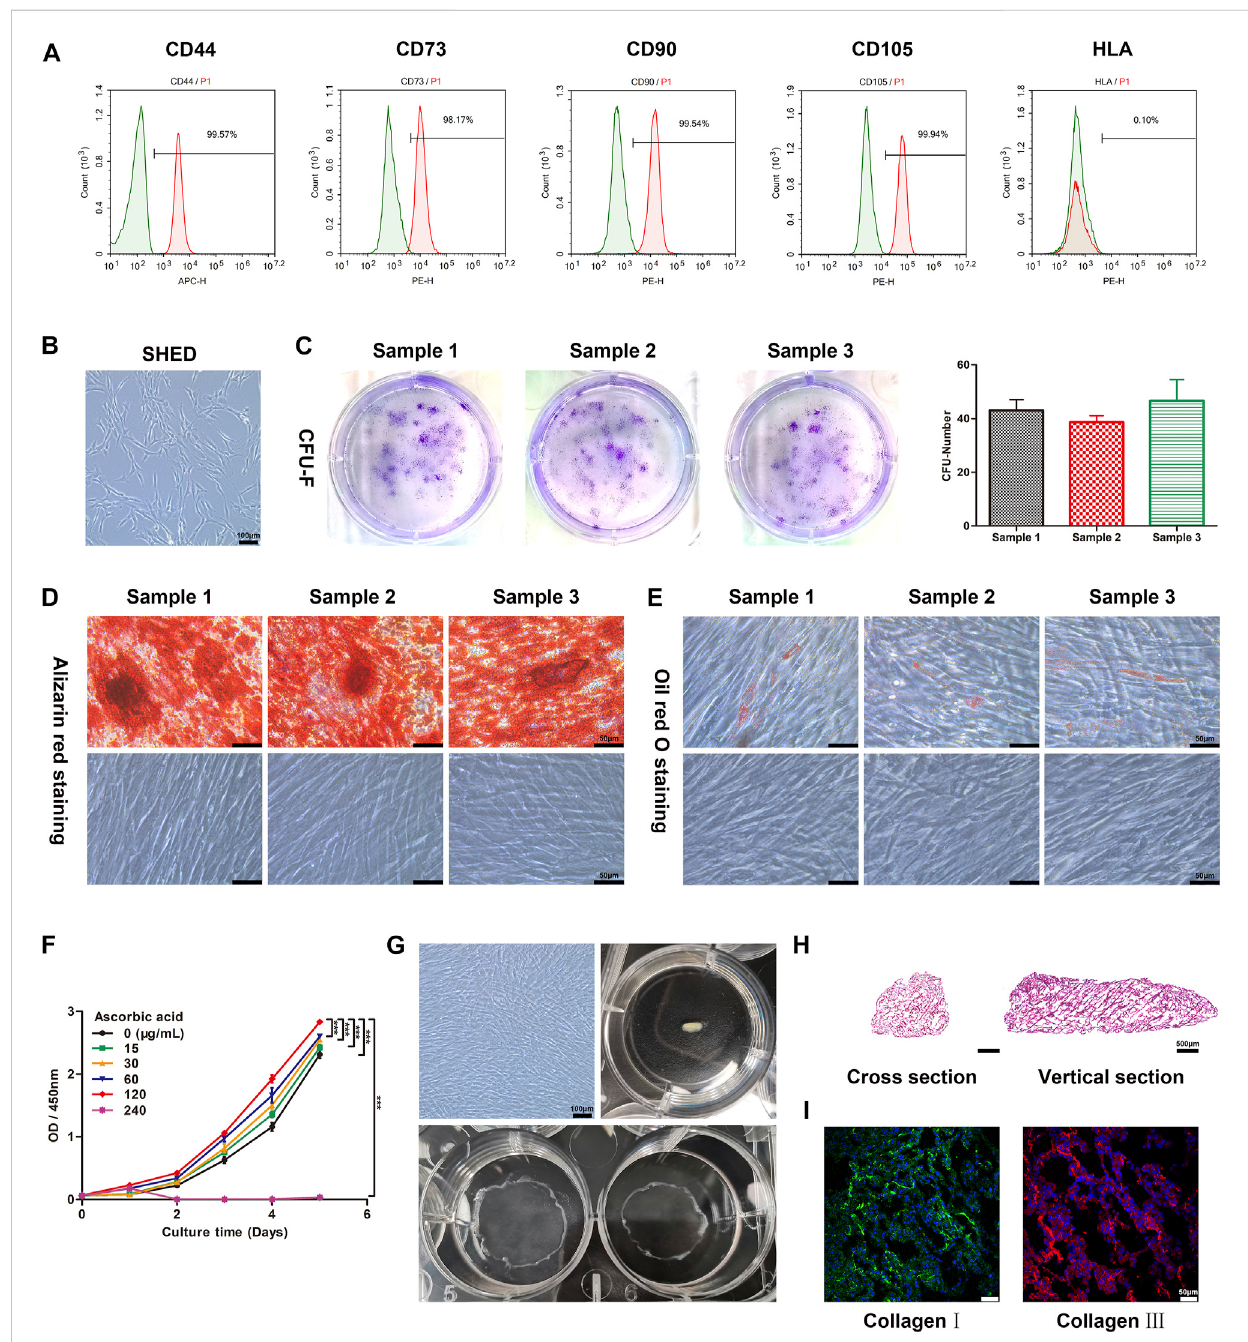
FIGURE 1 The construction and characteristics of hp-SHED sheet, which possesses a geometric structure similar to that of spinal cord tissue. (A) The surface markers of SHED, including CD44, CD73, CD90, CD105 and HLA were analyzed by fl ow cytometry. (B) Map of the morphology of the SHED. (C) SHED formed single CFU clusters in culture, the quantitative result was indicated in right panel. Data shown as mean ± SD. (D) Osteogenic differentiation of SHED. Alizarin red staining was performed at day 21 after osteogenic induction. (E) Adipogenic differentiation of SHED. Oil Red O staining was performed at day 28 after adipogenic induction. (F) The proliferation curve of SHED with different concentrations of ascorbic acid (AA) was analyzed by CCK8 assay. (mean ± SD, *** p < 0.001). (G) Construction of hp-SHED sheet. (H) Representative images of hp-SHED sheet sections. (I) Collagens in hp- SHED sheet were characterized by